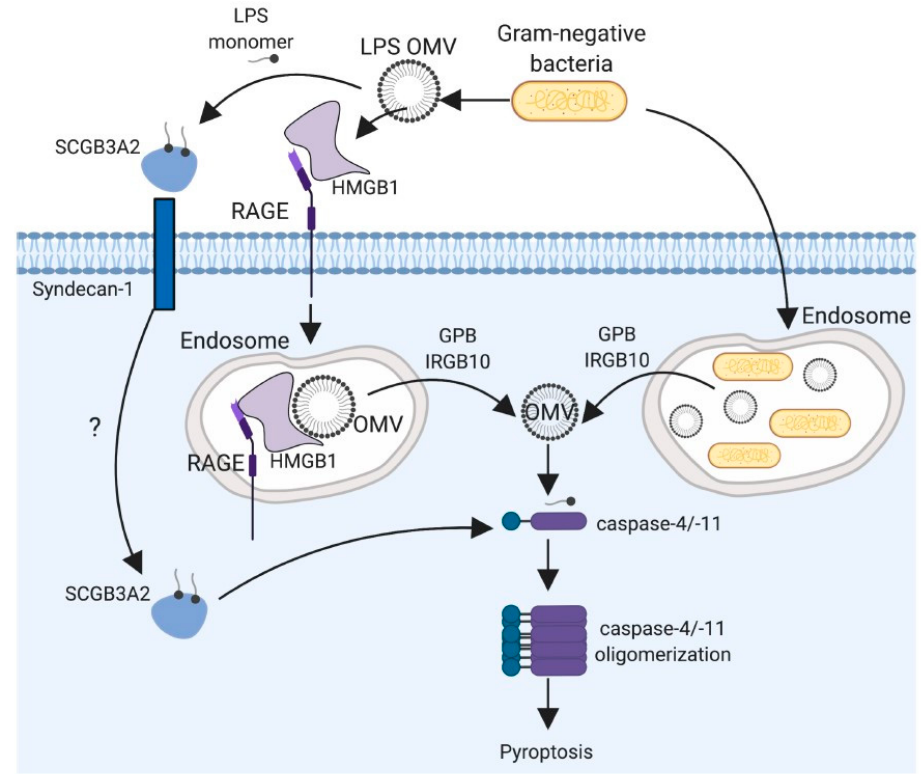
Figure 4. LPS recognition by caspase-4 / -11. LPS can access cytosol when Gram-negative bacteria disrupt the phagolysosome or by the uptake of LPS-containing outer membrane vesicles (OMVs) released by live bacteria and their subsequent lysis. The uptake of LPS / OMV is facilitated by HMGB1. The HMGB1–LPS complexes are internalized into endosomes through a receptor for advanced glycation end-products (RAGEs). LPS is released into cytosol after HMGB1 permeabilizes the phospholipid bilayer under acidic conditions. In addition, host GBPs and IRGB10 can facilitate the release of LPS from endosomes. Secretoglobin (SCGB)3A2 binds LPS, and the SCGB3A2–LPS complex can access cytosol (via an unknown mechanism indicate by “?” in the figure) through binding with the cell surface receptor syndecan-1. Once the LPS is delivered into the cytosol, caspase-4/-11 senses LPS, leading to its oligomerization and induction of pyroptosis.